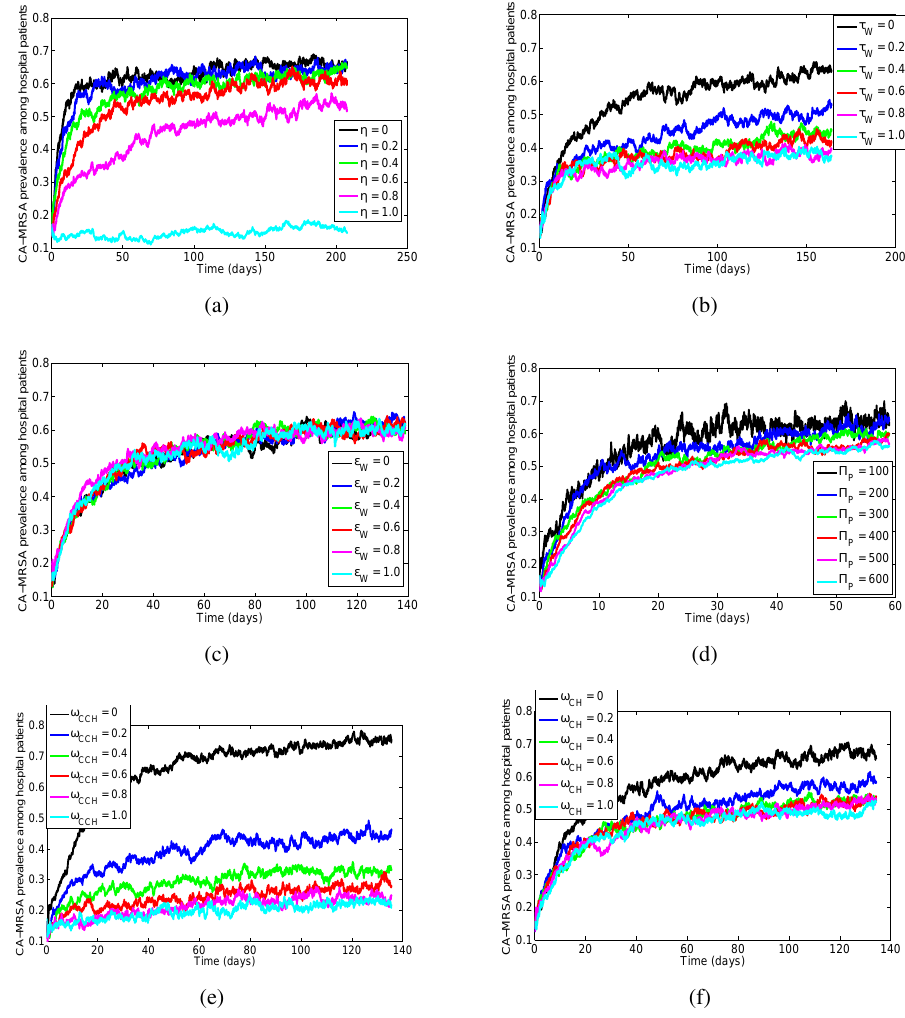
Fig. 7. Simulation of stochastic model (2.1) using the prevalence of CA-MRSA among hospital patients as model output. Varying: (a). hand washing compliance rate ( η ); (b). health-care workers decontamination rate ( τ W ); (c). environmental contamination rate ( (cid:15) W ); (d). hospital admission per day ( Π P ); (e). isolation rate of colonized patients with CA-MRSA ( ω CCH ); (f). isolation rate of colonized patients with HA-MRSA ( ω CH